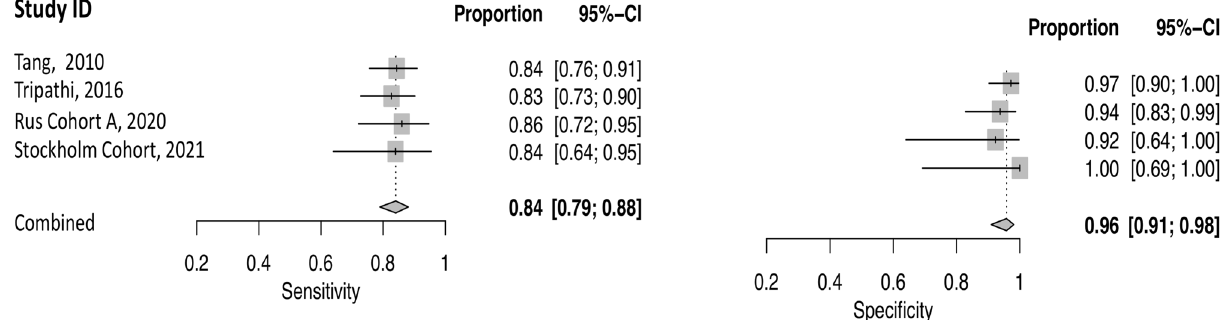
Figure 3. Forest plot of the included studies presenting sensitivity and specificity of each study along with the combined measures—first level of classification model, PD vs